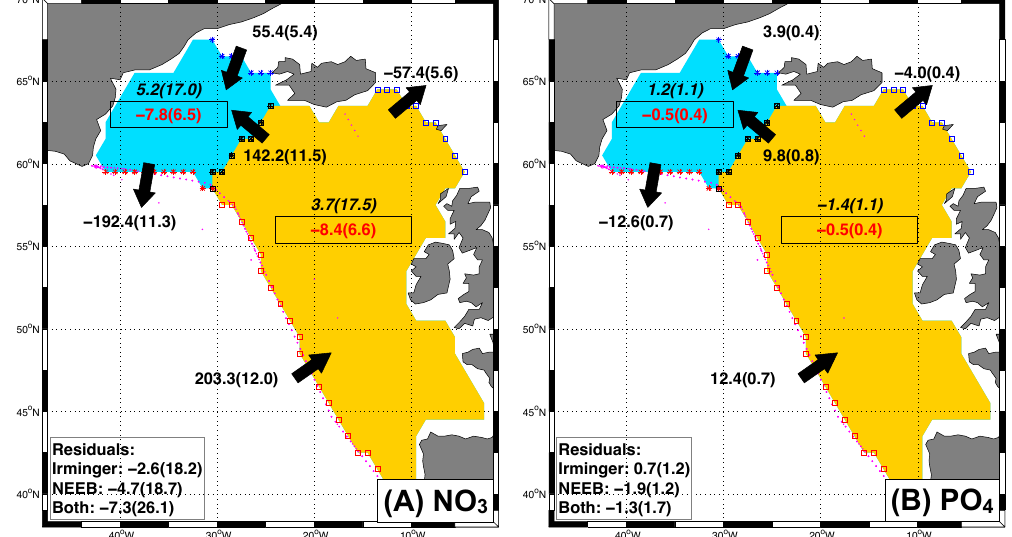
Fig. 2. (A) Nitrate and (B) phosphate budget terms in kmol s − 1 . Values are net for each box – i.e. negative value reducing concentration – except for the transport through RR, which is plotted for the Irminger box (sign needs to be changed for the NEEB box). Black arrows indicate the transport direction. In the center of each box, italic values are transport divergence and framed red values are the biological net source/sink term. In the lower left corner are indicated the box and domain residuals, i.e. the left-hand sides of Eqs. (2)–(3). Values within parenthesis are error estimates.